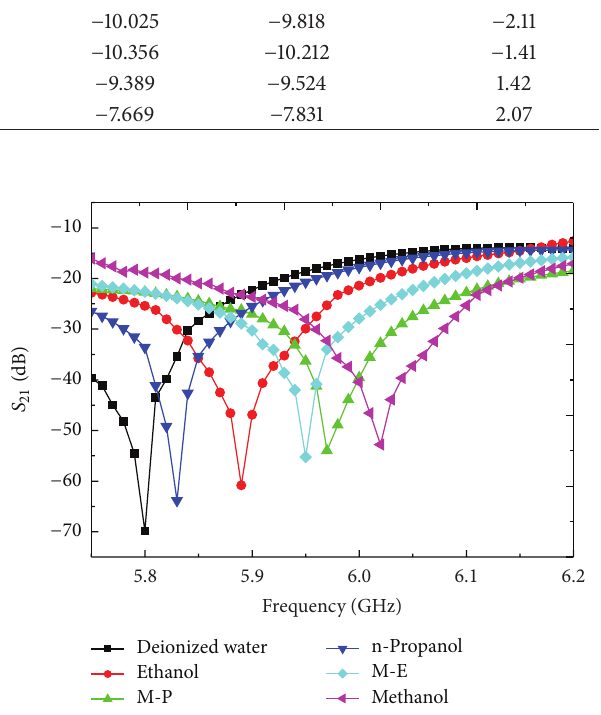
Figure 2: Measured 𝑆 21 for different LUT under the RFL which is deionized